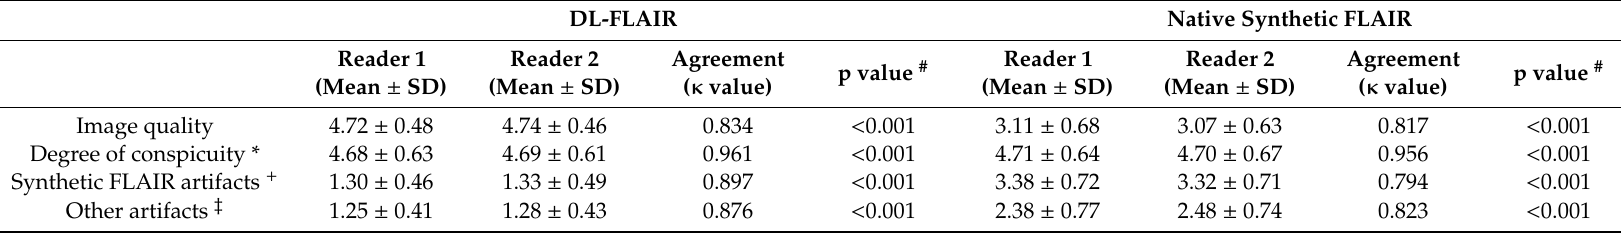
Table 3. Qualitative assessment of each reader on DL-FLAIR and native synthetic FLAIR images in all 319